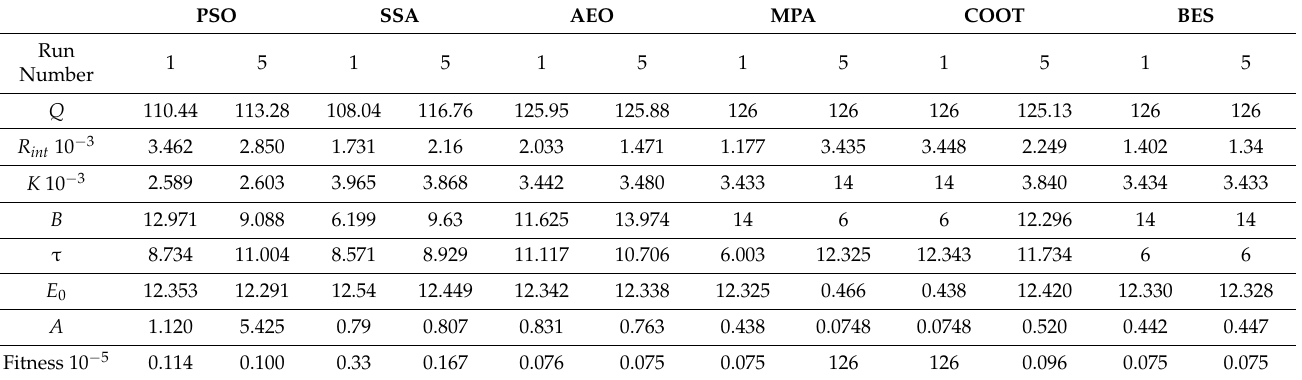
Table 7. Identification results for Banner battery case.